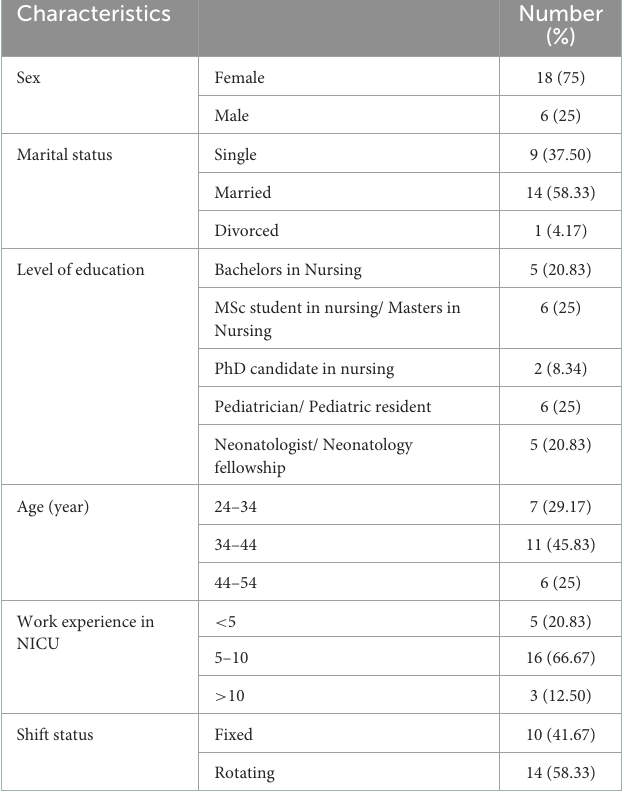
TABLE 2 Participations demographic characteristics ( n =